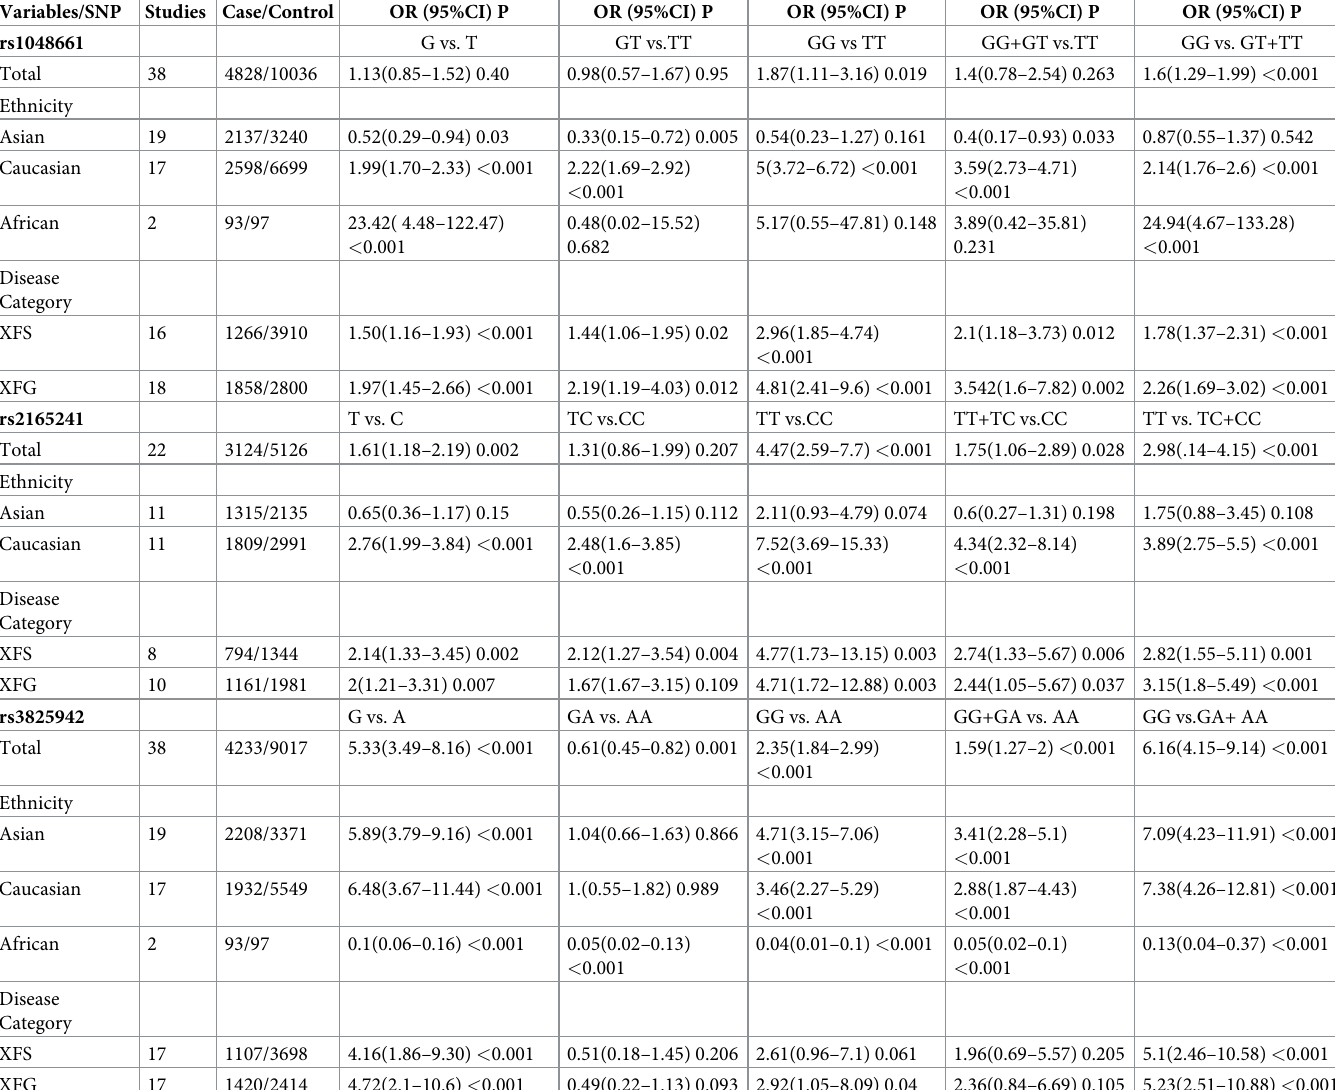
Table 2. Summary of different comparative results on LOXL1 gene polymorphism (rs1048661, rs2165241,